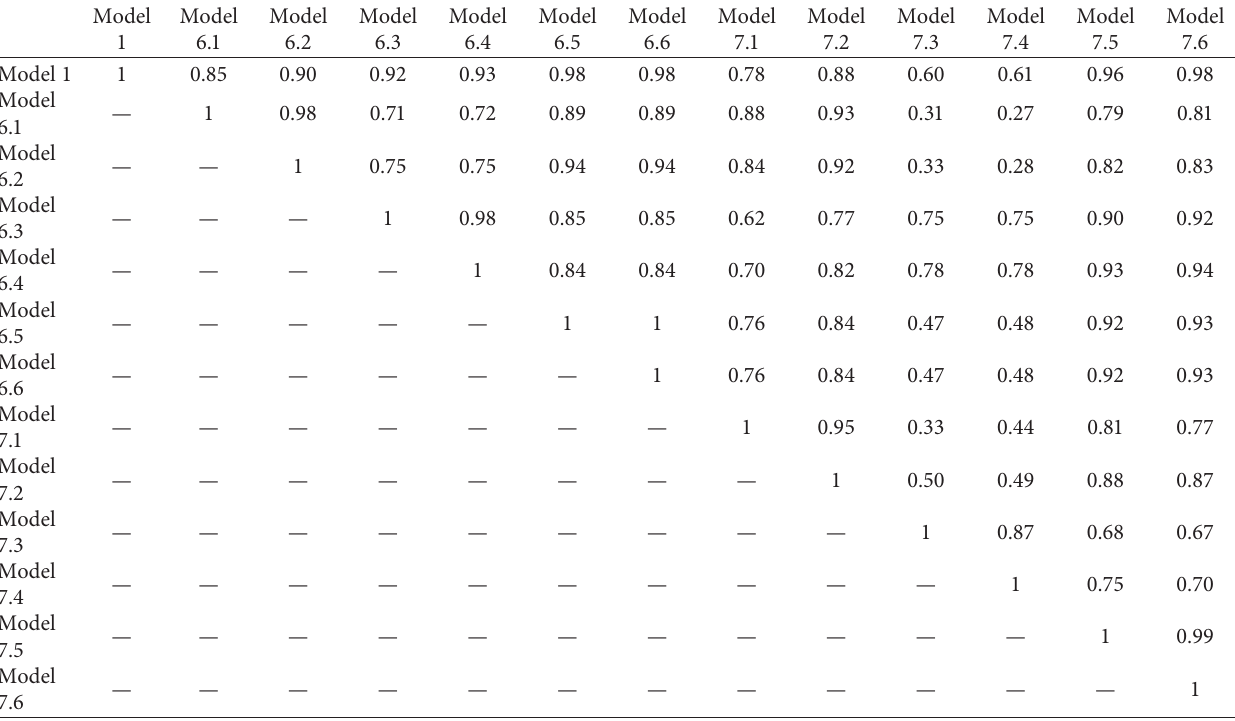
Table 22: Correlation of the ranks in the models 1, 6, and 7.